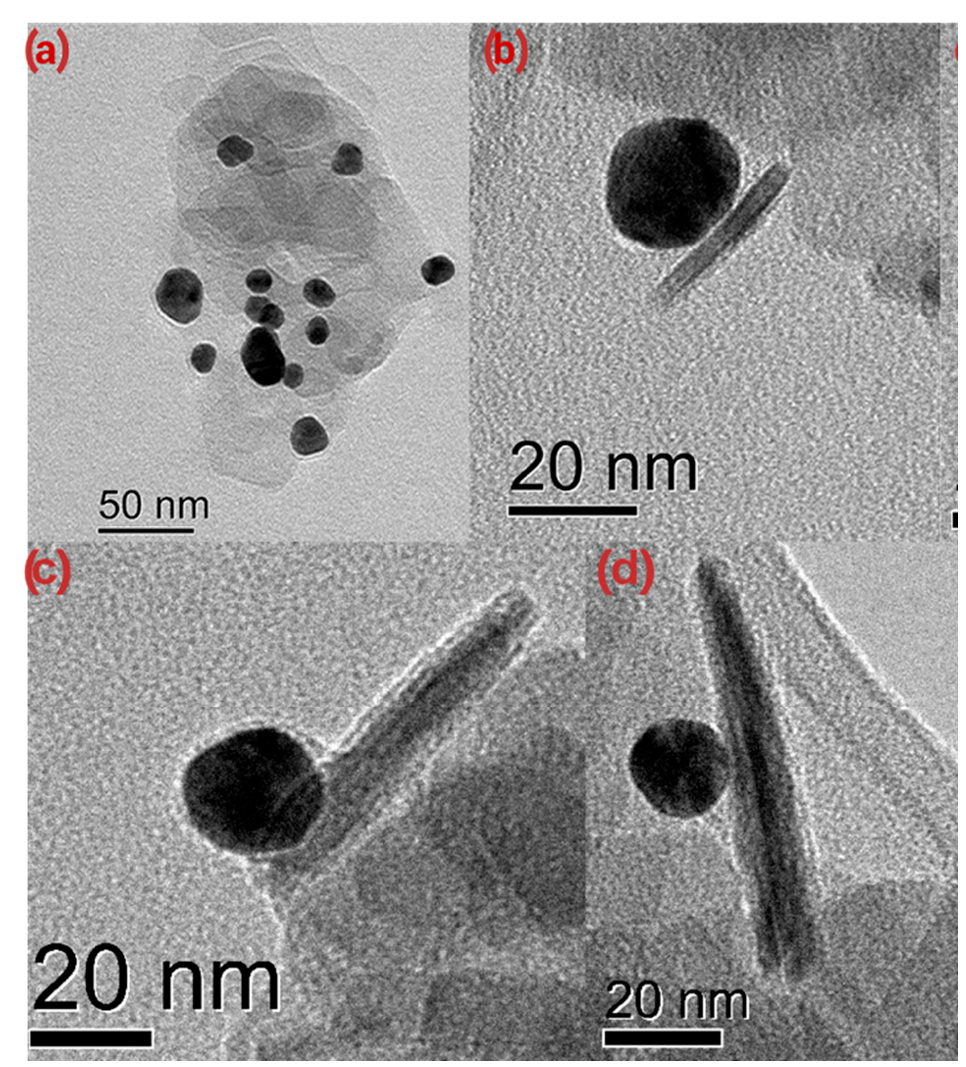
Figure 8. ( a ) Janus NPLs decorated with Au on only one side; ( b – d ) a single barium hexaferrite/gold Janus NPL.